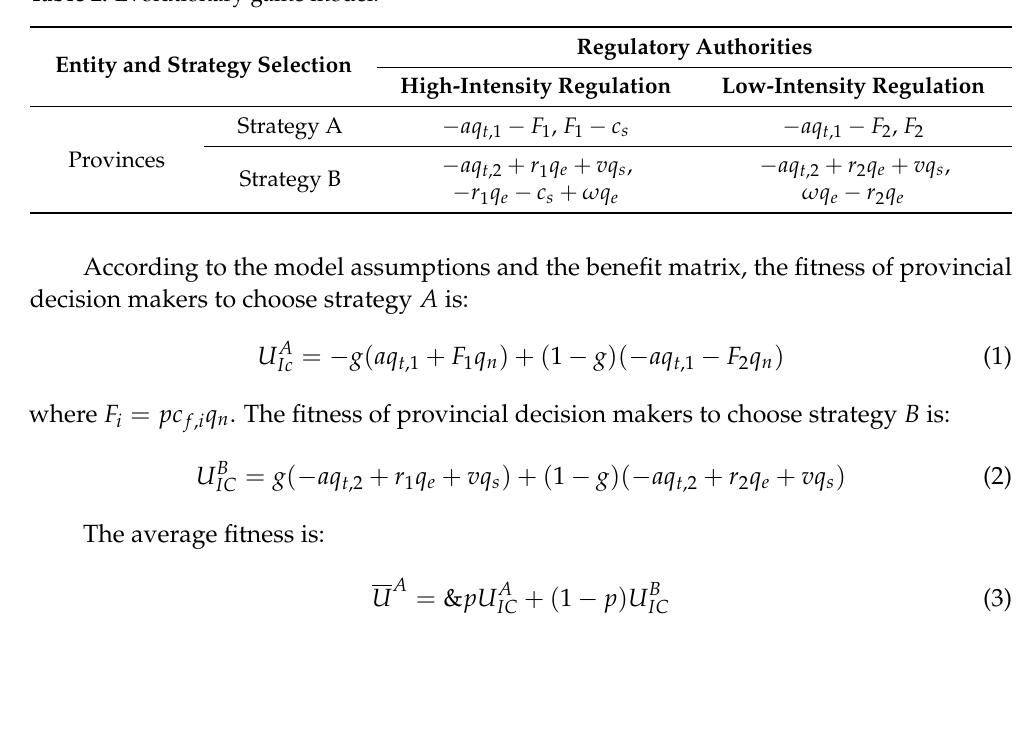
Table 2. Evolutionary game